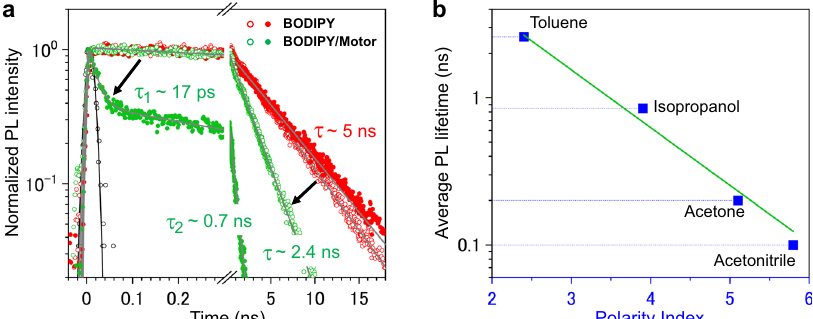
Fig. 4 | Depopulation of the S 1 excited state of BODIPY/Motor in different solvents. a Time-resolved PL transients of BODIPY (red) and BODIPY/Motor (green)intoluene(opendots)andinacetone( fi lleddots)under510nmexcitation. ThePLtransientswereobtainedbyintegratingthePLmaps(SupplementaryFig.16) in the 520 (cid:3) 600nm spectral region, where PL of BODIPY occurs. The gray curves show the fi ts to exponential functions convoluted to the Gaussian apparatus function. The fi tting parameters of the exponential functions are summarized in SupplementaryTable11.The blackarrowsdepictthe PLquenching uponattaching